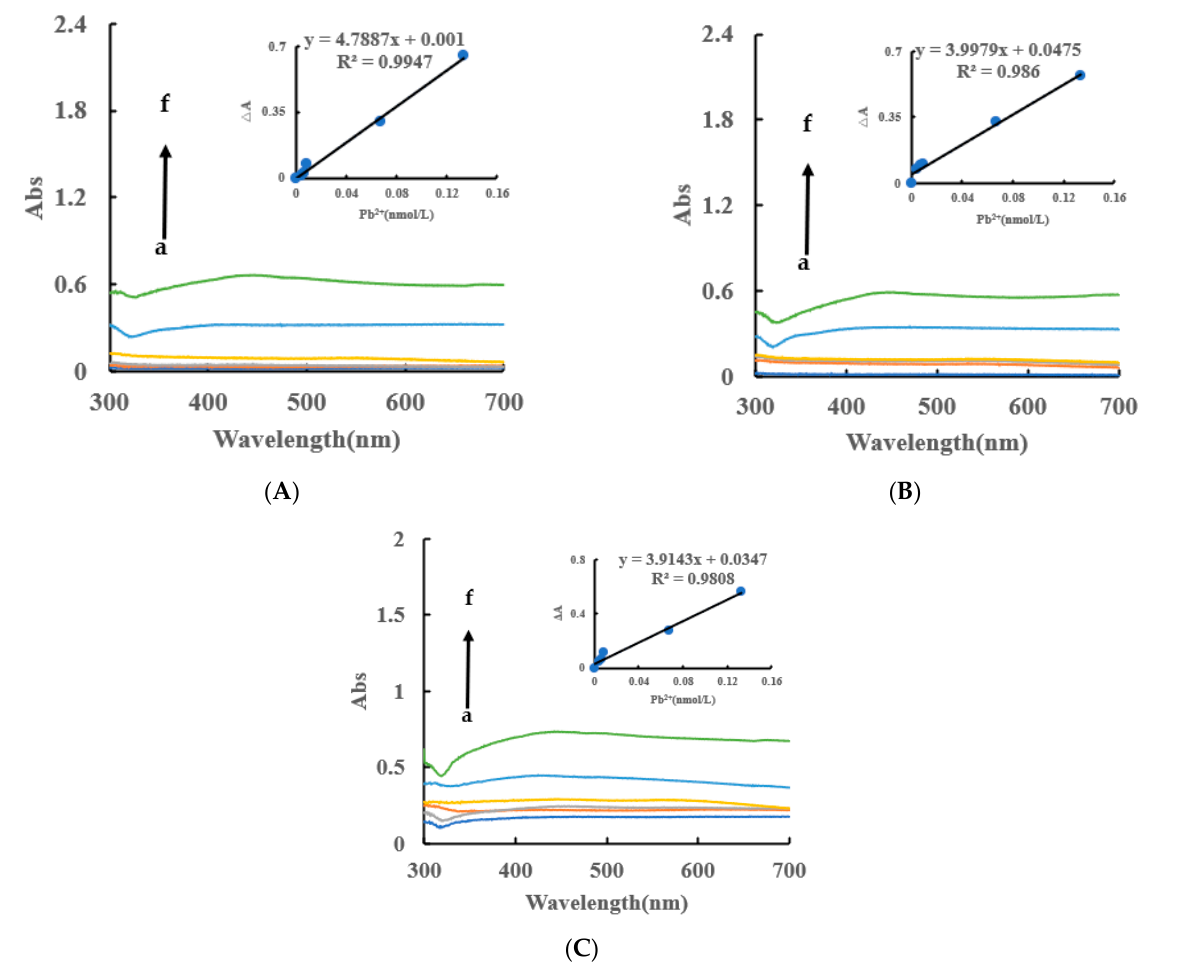
Figure 6. Abs spectra of an Apt Pb -CB@AgNPs -Fo-AgNO 3 -Pb 2+ system. ( A ): a-f: (0, 4.47 × 10 − 3 , 6.7 × 10 − 3 , 8.94 × 10 − 3 , 6.7 × 10 − 2 , 0.133) nmol/L Pb 2+ + 0.667 nmol/L Apt Pb + 73.98 μ mol/L NaAc-Hac + 1.33